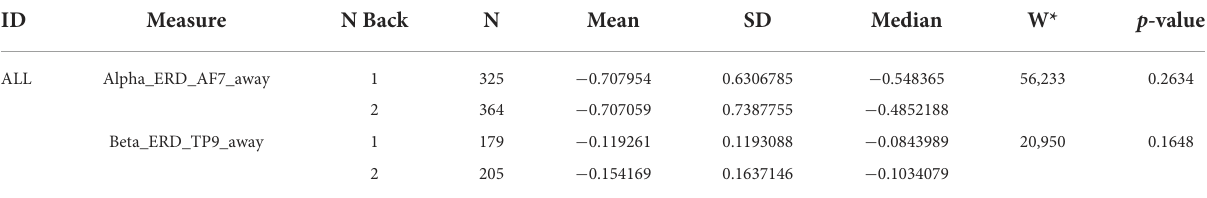
TABLE 4 The descriptive statistics and Mann–Whitney–Wilcoxon test results for averages of ERD of Alpha_AF7 and Beta_TP9 with baseline away between 1 back and 2